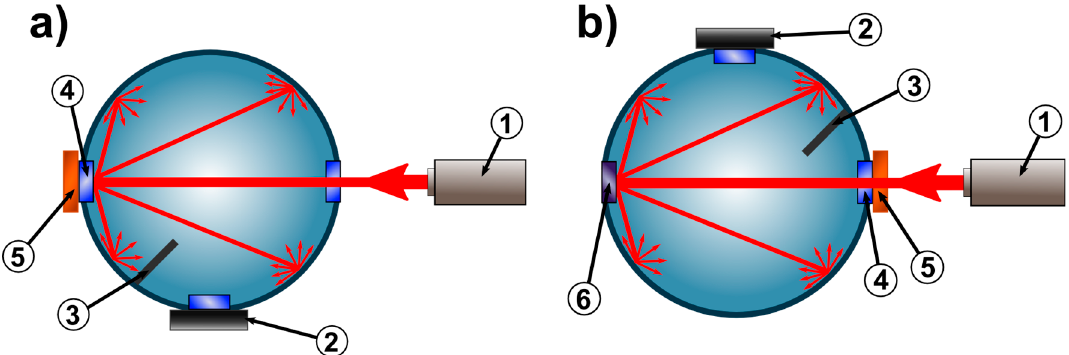
Figure 1. Measurement system. ( a ) Mode for the measurement of diffuse reflectance R d , ( b ) mode for the measurement of diffuse transmittance T d . 1—Light source, 2—detector, 3—baffle, 4—sample port, the measurement of di ff use transmittance T d . 1—Light source, 2—detector, 3—ba ffl e, 4—sample port, 5—examined sample, 6—unused plugged port. 5—examined sample, 6—unused plugged